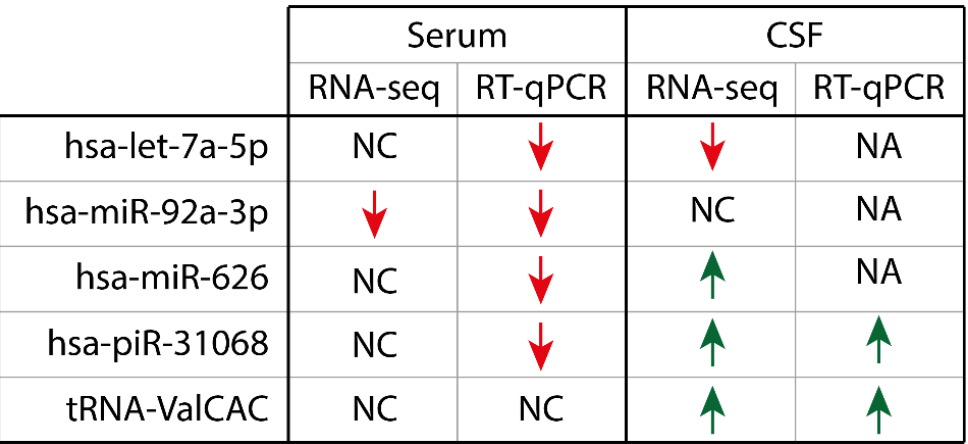
Figure 4. Summary of the dysregulation detected in the serum and CSF in patients with PSP compared to healthy controls. NC: no change, NA: no amplification. Red down arrow = Down-regulation, Green up arrow =